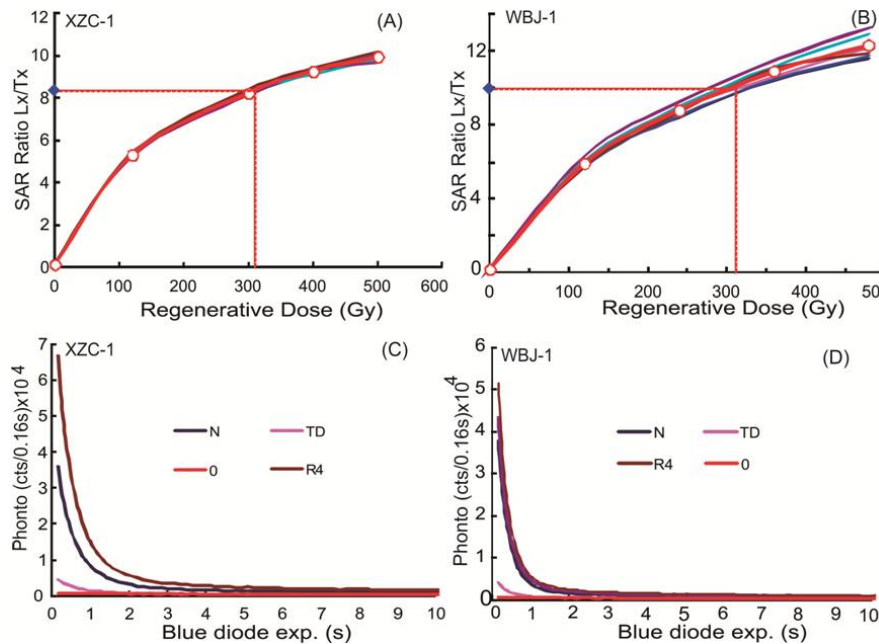
Figure 6. ( A , B) showing growth curves of individual aliquots WBJ ‐ 1 and XZC ‐ 1, with basal Figure 6. ( A , B ) showing growth curves of individual aliquots WBJ-1 and XZC-1, with basal figures figures showing decay curves ( C , D ). showing decay curves ( C , D ).